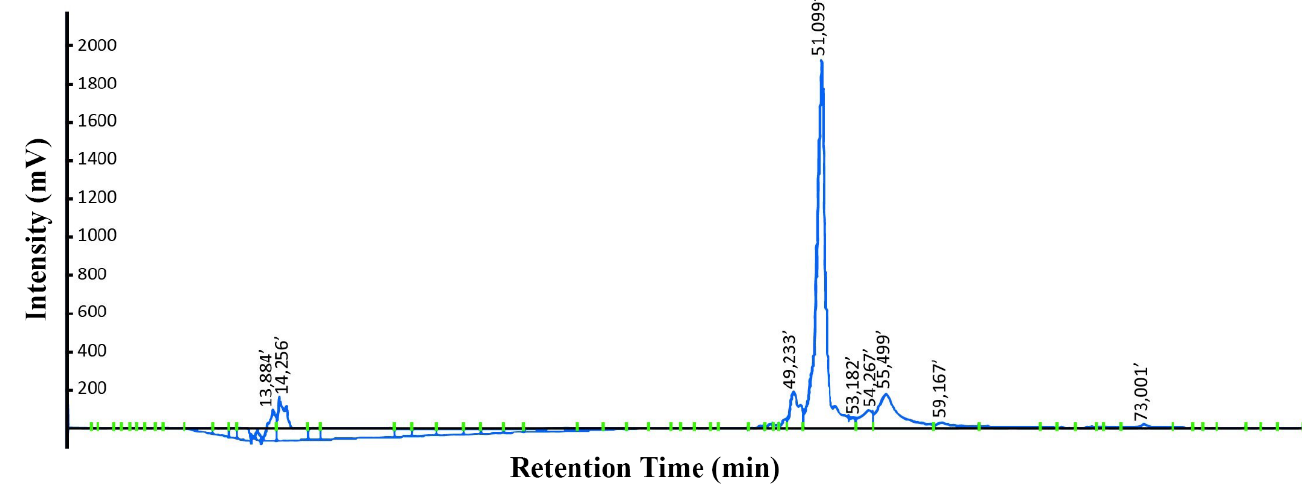
Figure 5. Reversed-phase HPLC purification of KR12AGPWR6 after intein’s self-cleavage. The samples were resuspended with 6 M guanidine hydrochloride and purified by reversed-phase HPLC on the Prominence HPLC System equipped with a C18 column. The column was equilibrated with ddH 2 O containing 0.1% ( v / v ) trifluoroacetic acid (TFA) and the gradient ranging from 15 to 100% ( v / v ) methanol containing 0.1% ( v / v ) TFA for 75 min at a flow rate of 1 mL/min. Signals were detected by UV 280 nm.